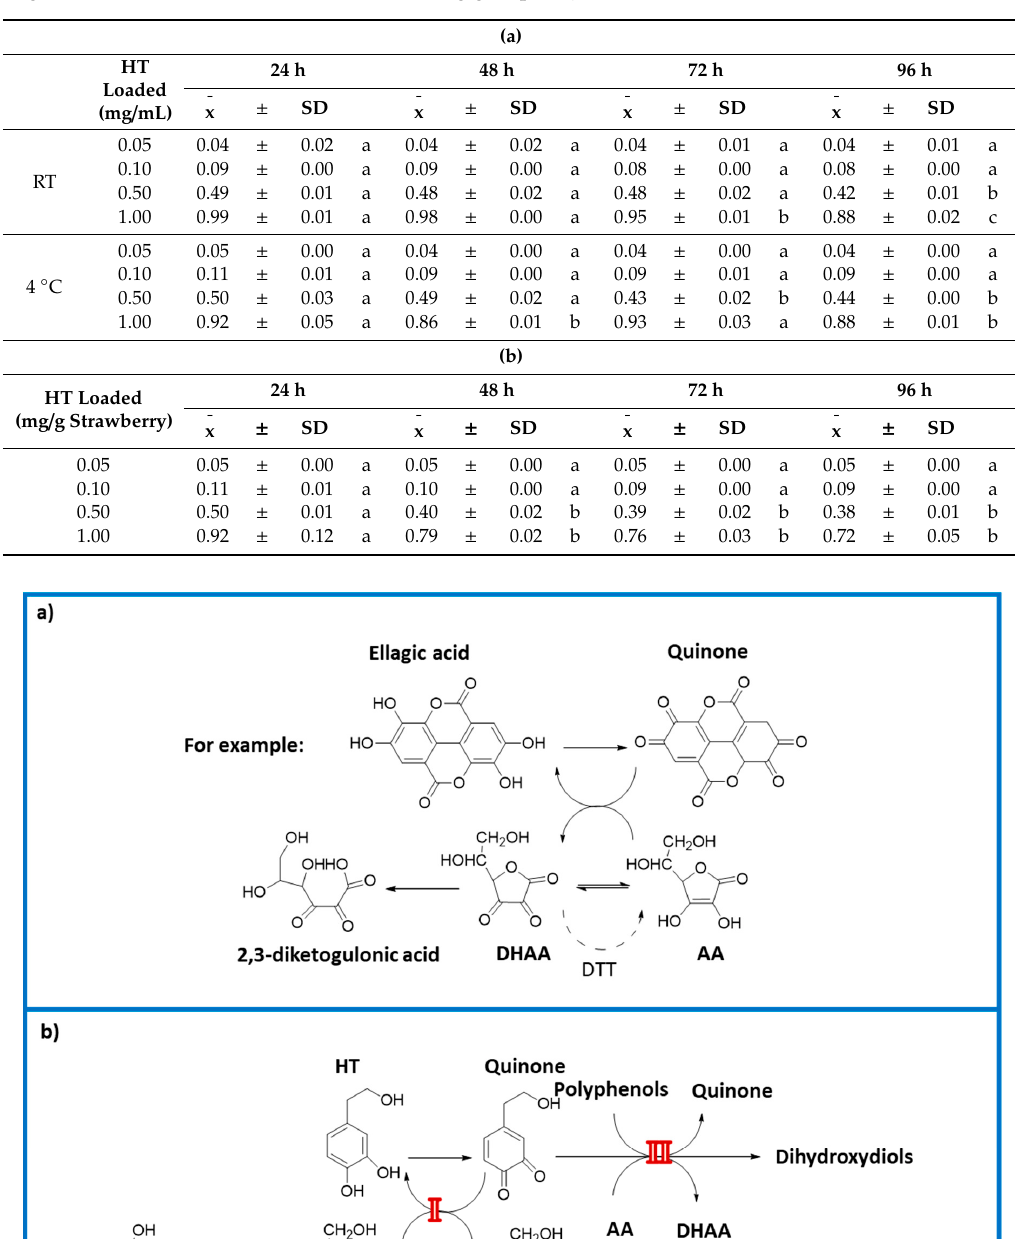
Table 1. Evolution of the concentration of hydroxytyrosol (HT) added to a model system solution of ascorbic acid during storage at room temperature (RT) and at 4 ◦ C ( a ), and added to a strawberry puree during storage at 4 ◦ C ( b ). The data are show as mean ± SD of duplicates. Letters (a–c), indicate significant di ff erences of concentration among groups at p < 0.05.